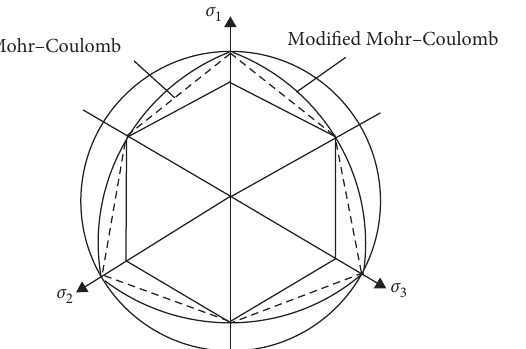
Figure 8: The modified Mohr–Coulomb yield criterion in the π plane. Table 2: Parameters of soil surrounded layers after calibration. Soil